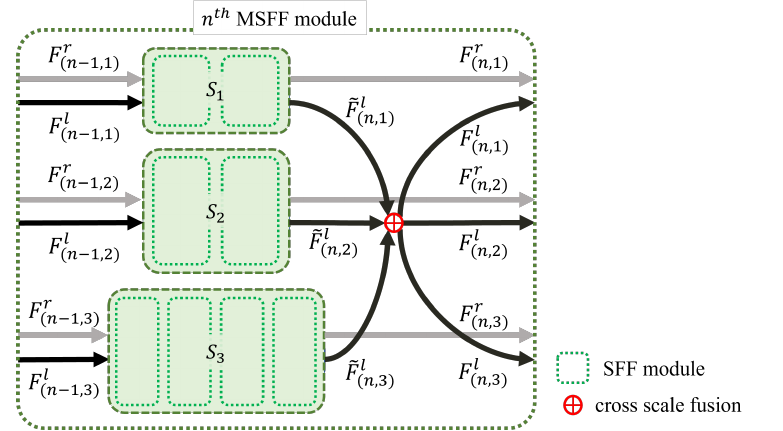
Figure 3. Details of the proposed MSFF module.